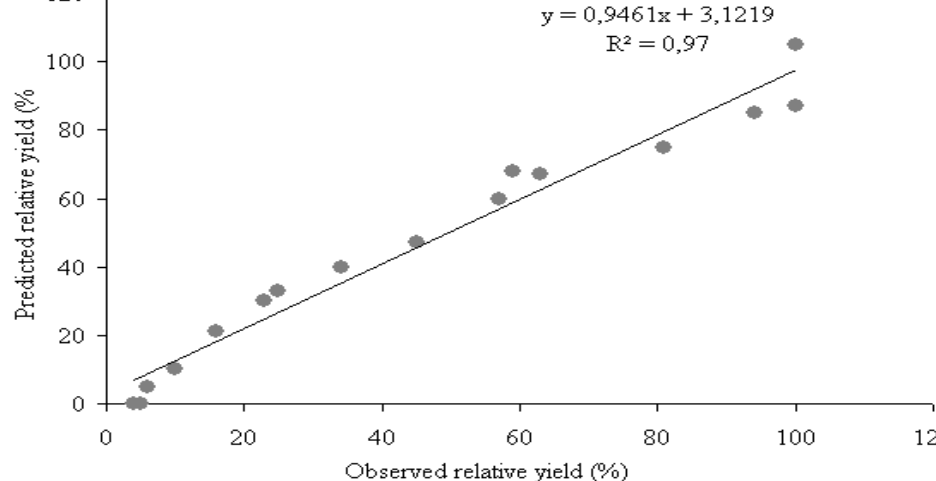
Figure 4. Relationship between total simulated and observed relative Sweet Corn and lettuce relative